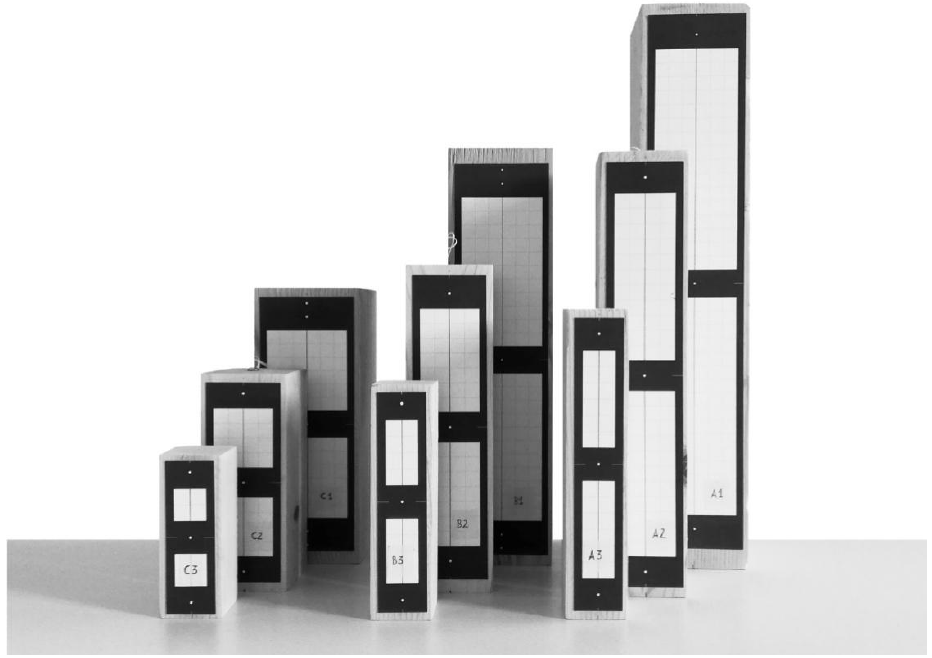
Figure 2. Tested specimens.